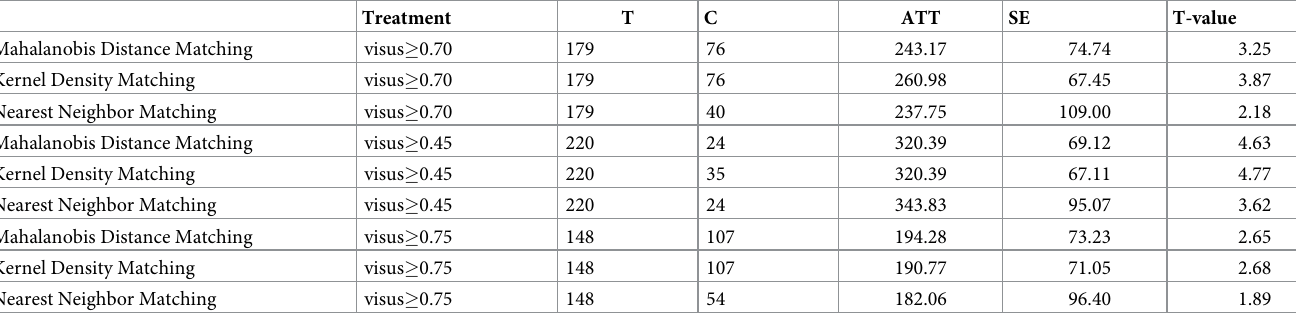
Table 8. Treatment effects of visual acuity on single factor productivity.